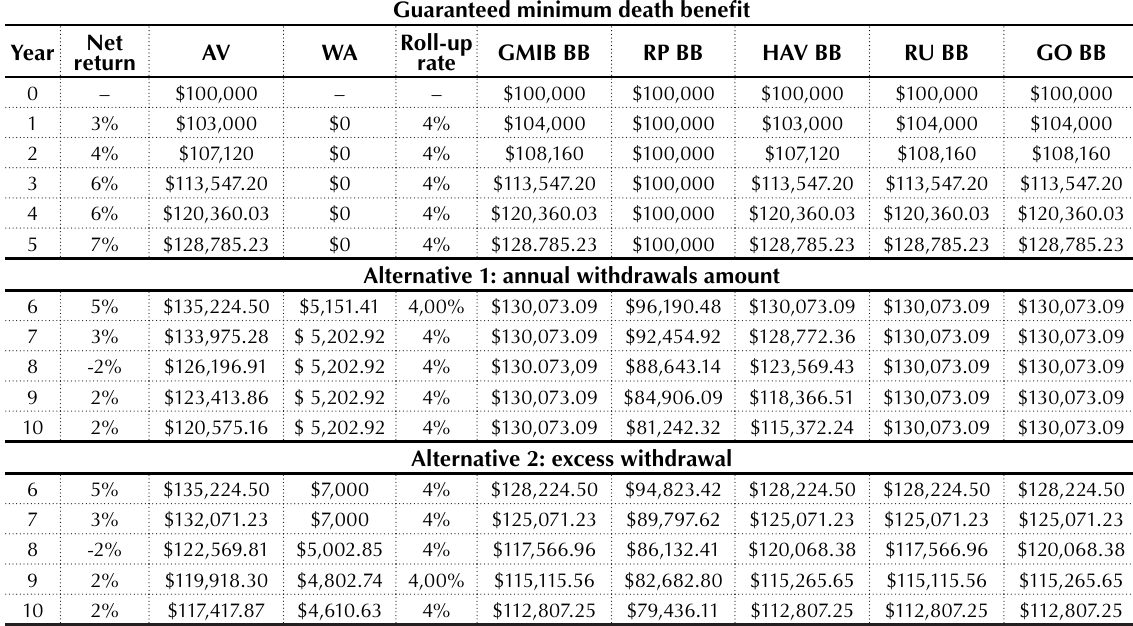
Table 4. GMIB and GMDB behavior given policyholder’s withdrawals when the account value is greater than the GMIB benefit base at the time of the first withdrawal Guaranteed minimum death